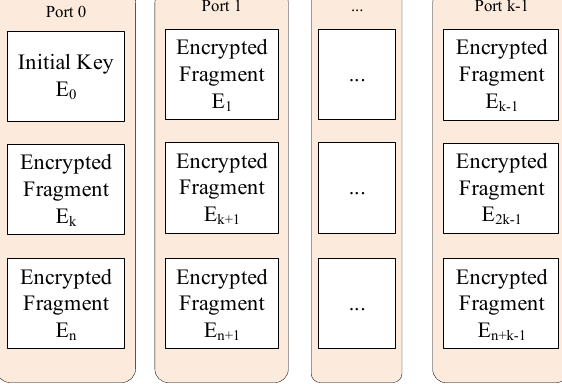
Figure 5. Send Encrypted Fragments through Corresponding Ports